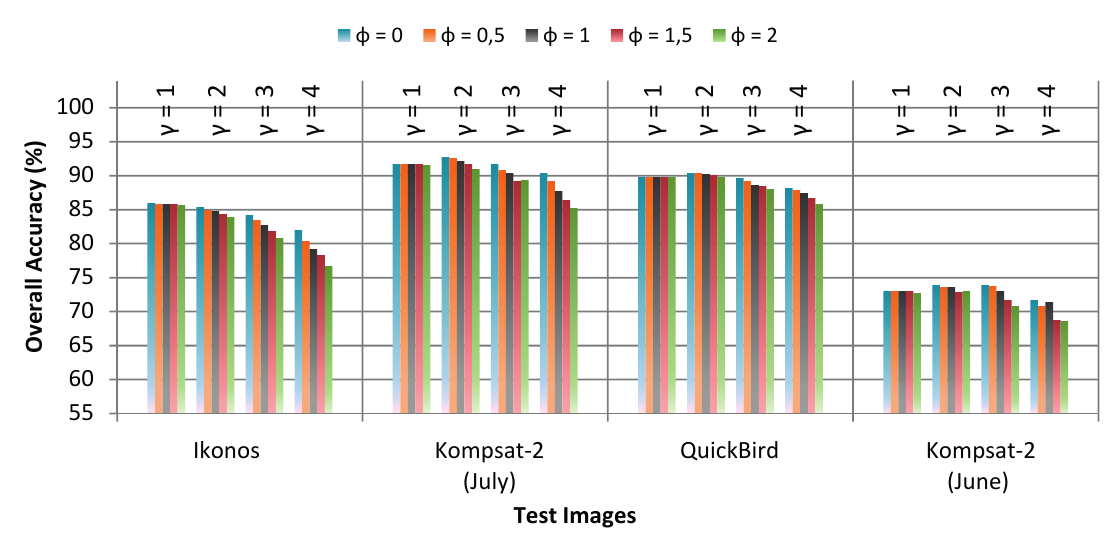
Figure 14. Overall accuracies of SVM-LCS vs. truncated linear potential function constant ( ϕ